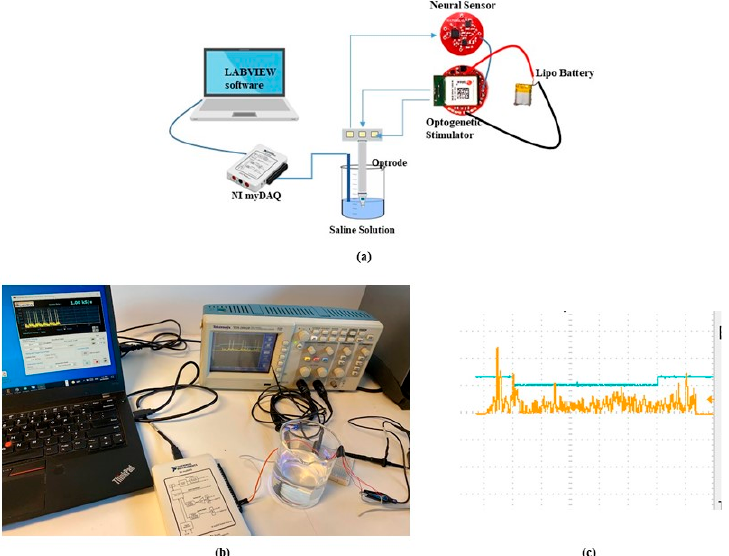
Figure 13. Experimental design for the neural sensor with: ( a ) sinusiodal signal of frequency 38 Hz and ( b ) sinusoidal signal of 1 kHz ( c ) output of the neural sensor (in yellow) and the stimulation pulses (in blue) on an oscilloscope.